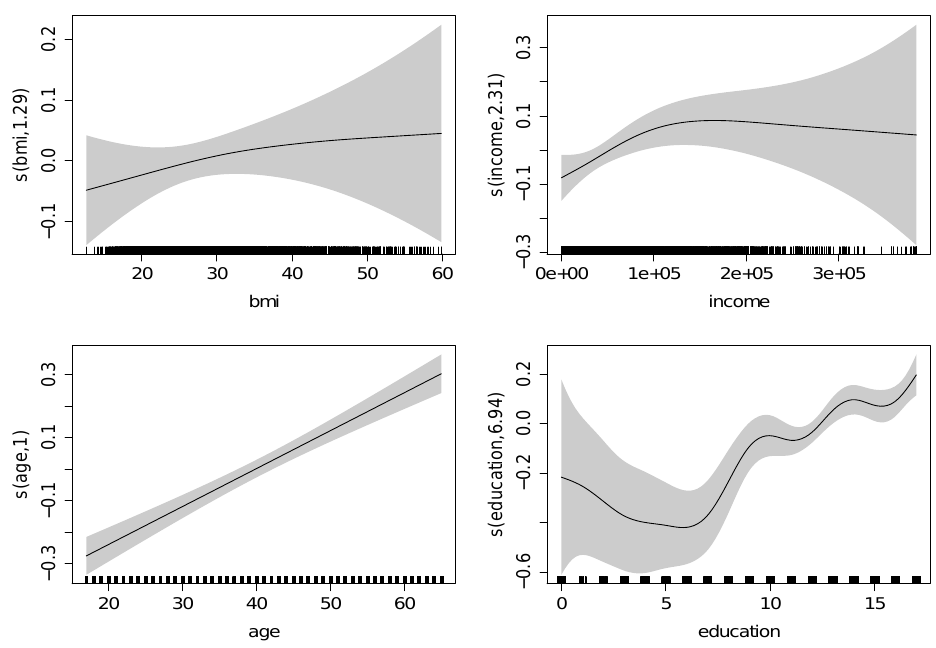
Figure 2: Outcome equation: smooth function estimates and associated 95% point-wise confidence intervals obtained by fitting the Clayton180 copula model on the 2008 MEPS data. Results are plotted on the scale of the additive